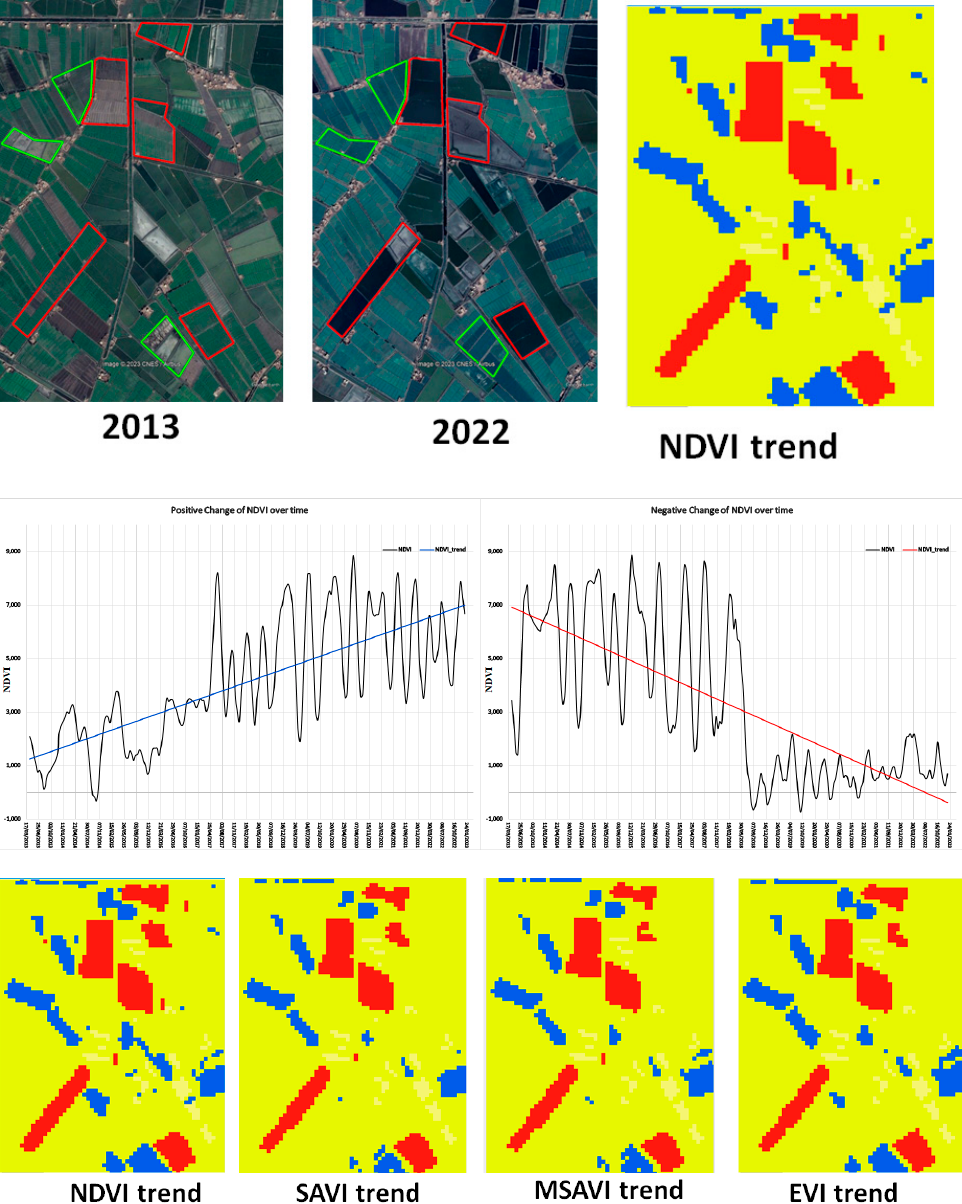
Figure 10. Negative and positive object detection using trend analyses. Both soil moisture and drought have been taken into account when adjusting re- gions with positive and negative patterns in vegetation productivity. When compared to soil data, RSI trend concordance plainly demonstrates SD areas. When compared to re- gions with significant negative trends based on soil moisture, areas with significant neg- ative trends based on vegetation indices at 95% significant level were also found to be relatively negative. The RSI shows a positive tendency when compared to soil data when the distribution of positive and negative trends is examined. Vegetation indexes and soil moisture distribution both exhibit a largely positive tendency. On the other side, the sa- linity indices overwhelmingly display a positive tendency. This suggests that drought and soil moisture have a great impact on SD processes. The majority of the energy from the visible to the infrared spectrum, particularly for the SWIR1 and SWIR2 channels, is drawn to water. These SWIR wavelengths are ab- sorbed by vegetation, whereas NIR energy that reaches vegetated surfaces primarily re-